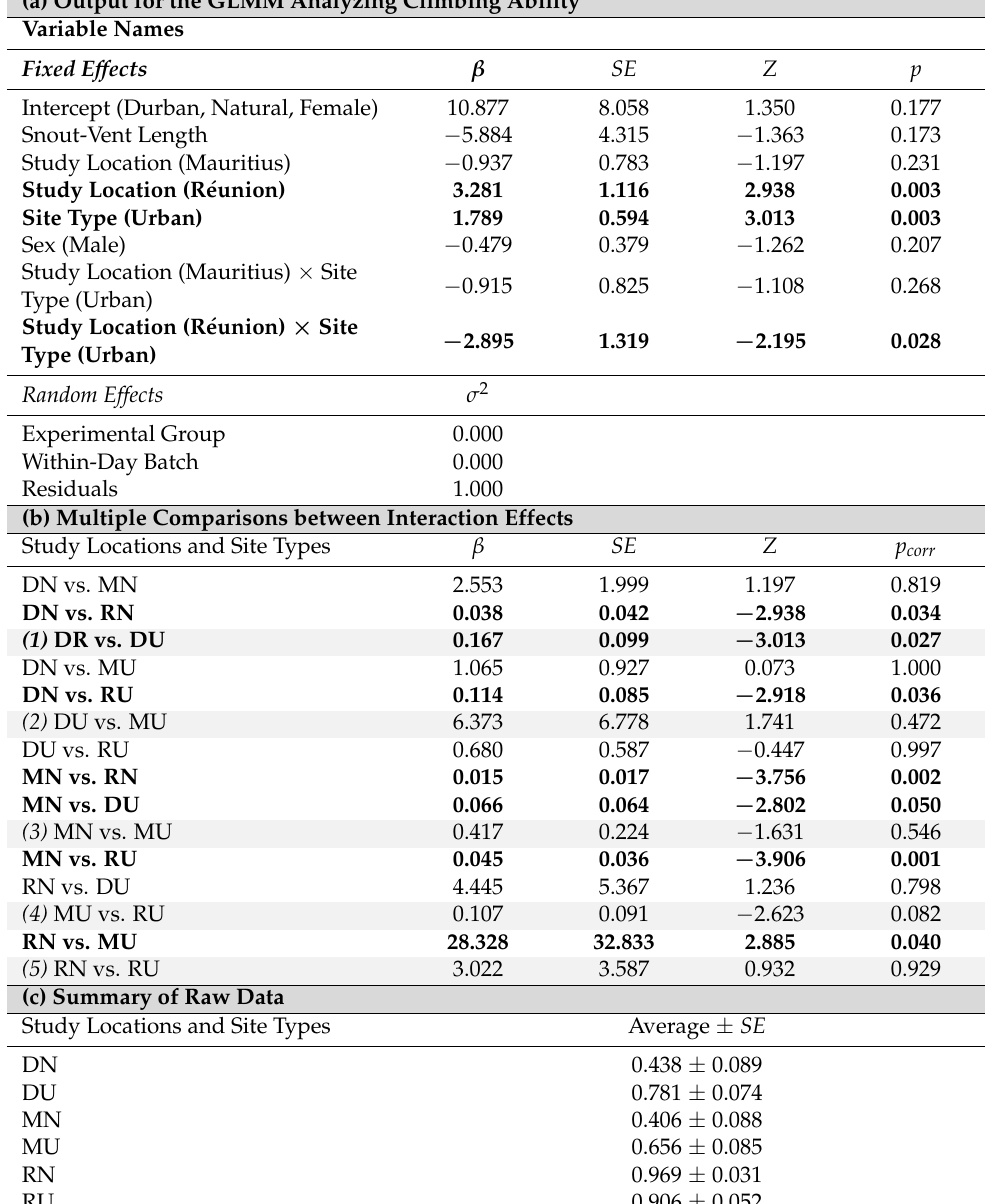
Table 8. ( a ) Outcome of the GLMM examining differences in guttural toad ( Sclerophrys gutturalis ) climbing ability. Coefficient estimates ( β ) of fixed effects are presented with their standard errors ( SE ), variance estimates ( σ 2 ) are supplied for residuals and random effects, and all significant values ( p < 0.05) are bolded. Reference levels for each categorical variable are supplied in brackets following the variable name. ( b ) Post hoc multiple comparisons of climbing ability between all interaction effects of study location (i.e., Durban = D, Mauritius = M, and R é union = R) by site type (i.e., natural = N and urban = U) and p -values ( p corr ) were corrected using an “ mvt ” adjustment [63]. These values are based on the response scale (i.e., back-transformed from the logit link and the latent scale). Stages of the hypothesized invasion route are numbered and highlighted in gray. ( c ) Summary statistics (average ± SE ) of the raw data for each study location and site type